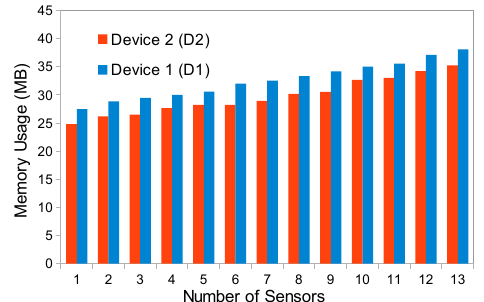
Figure 9. Comparison of Memory Usage by MOSDEN Client -